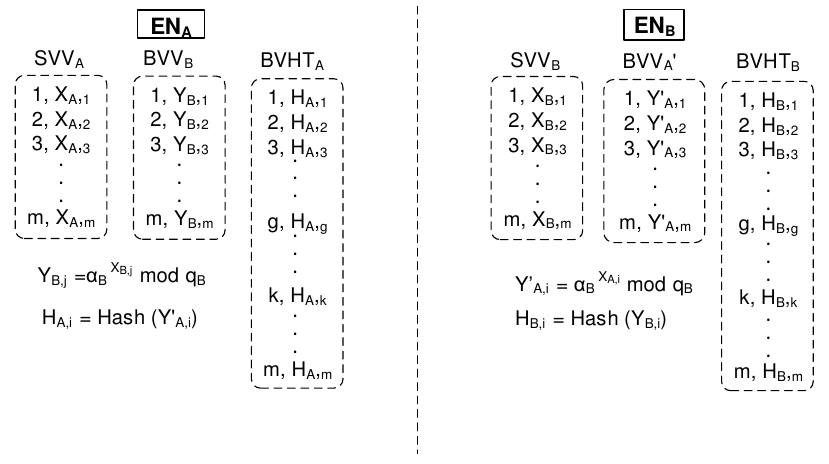
Figure 9. Security parameter agreements between peers.